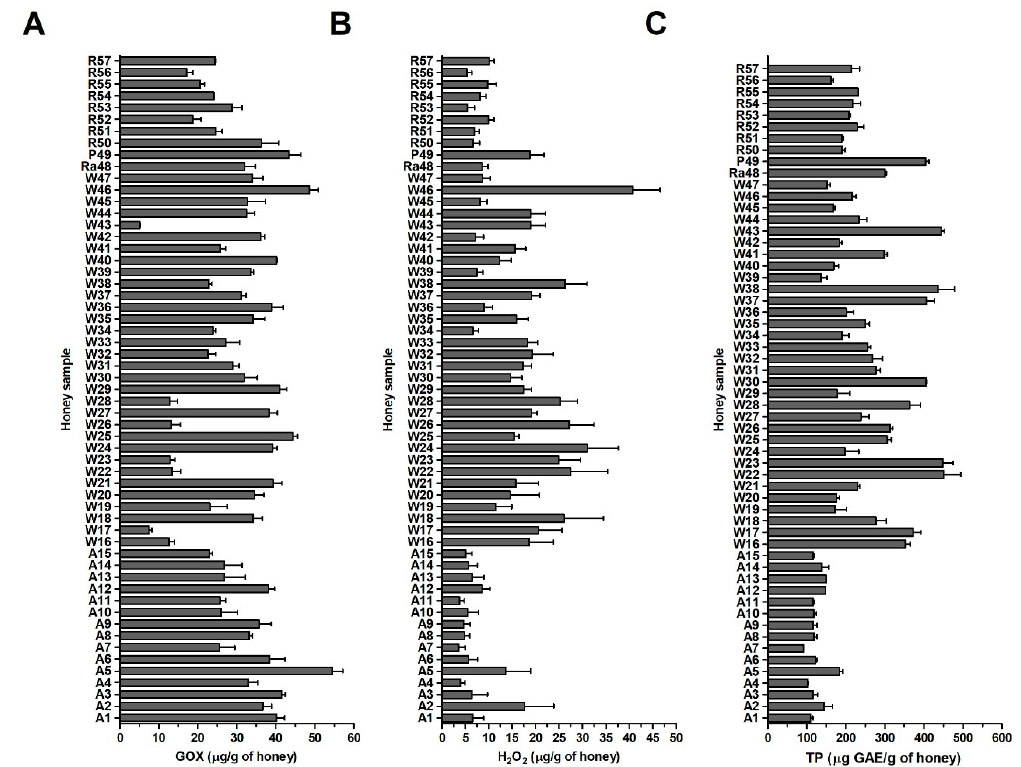
Figure 5. Glucose oxidase (GOX), hydrogen peroxide (H 2 O 2 ) and total polyphenol contents (TP) in blossom honey samples ( n = 57). ( A ) GOX content was determined using a semi-quantitative immunoblot assay ( B ) H 2 O 2 content was measured in diluted honey samples (40% ( w / w ), without previous incubation) with a modified GOX assay kit ( C ) TP content was determined with a Folin Ciocalteu Phenolic Content Quantification Assay Kit in 20% ( w / v ) honey solutions. Gallic acid (GAE) was used as the TP reference standard compound and results are expressed as GAE equivalents ( μ g GAE / g of honey). The data represent the mean values with standard deviation (SD).